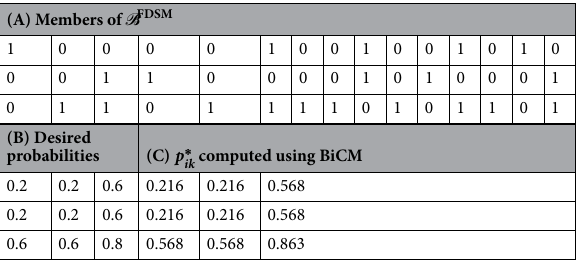
Table 1. SDSM probabilities given agent and artifact degree sequences [1,1,2].